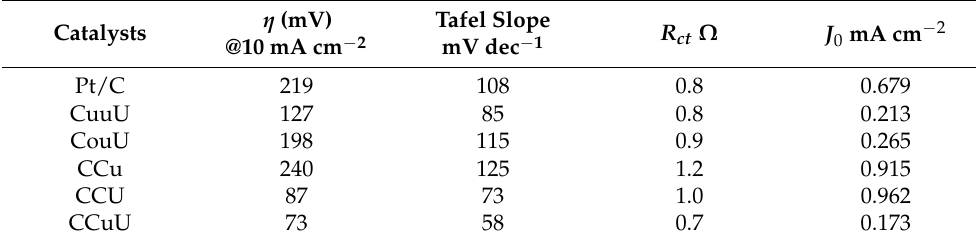
Figure 5. ( A ) LSV plots, ( B ) Comparison of overpotentials at different current densities, ( C ) Tafel plot, and ( D ) EIS diagram (inset: EEC) of catalysts in alkaline seawater (treated with 1 M KOH). Table 2. Account of the catalytic activities of the catalysts in alkaline seawater.